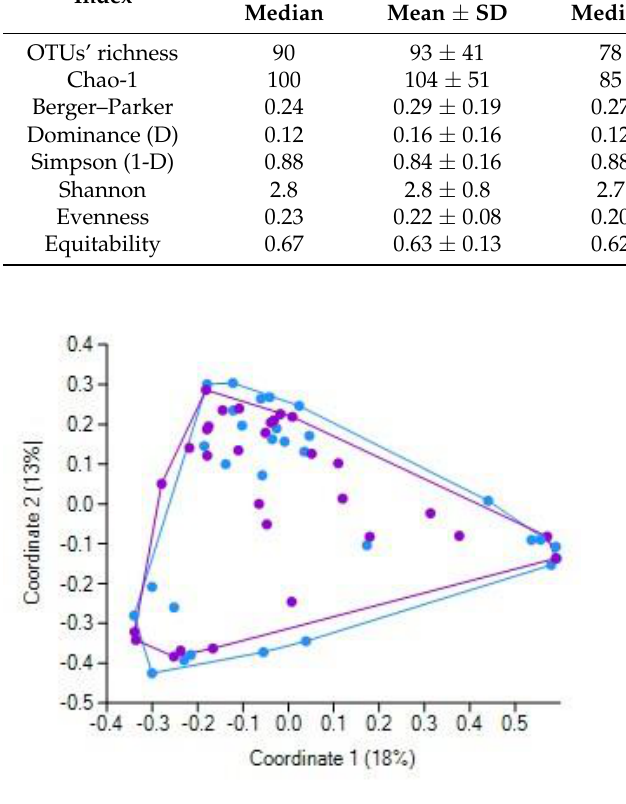
Figure 2. Location of patients’ samples taken before (violet markers) and after (blue markers) CCE in the plane of the first two principal coordinates (Bray–Curtis distance).